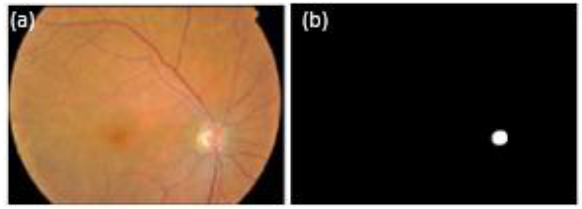
Fig. 1. The fundus image (a) and ground truth from expert (b)